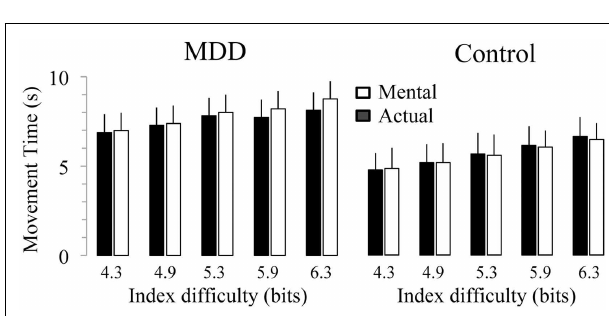
FIGURE 3 |Average ( ± SD) values of actual and mental movement times according to the index of difficulty (ID) for both groups . Star indicates significant differences between groups ( P <